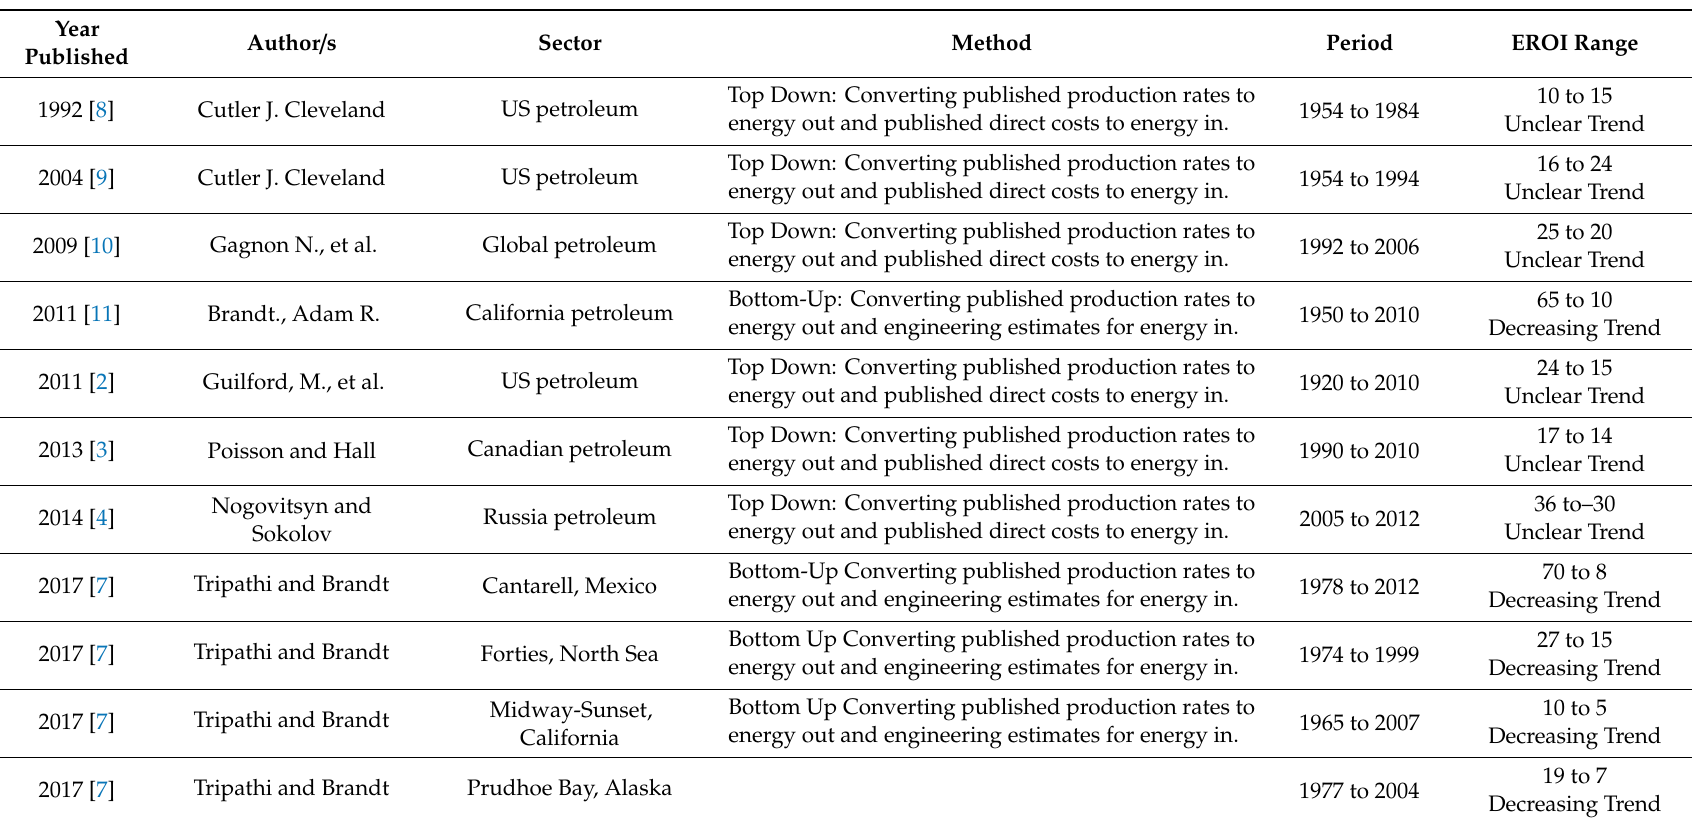
Table 1. Previous energy return on investment (EROI)